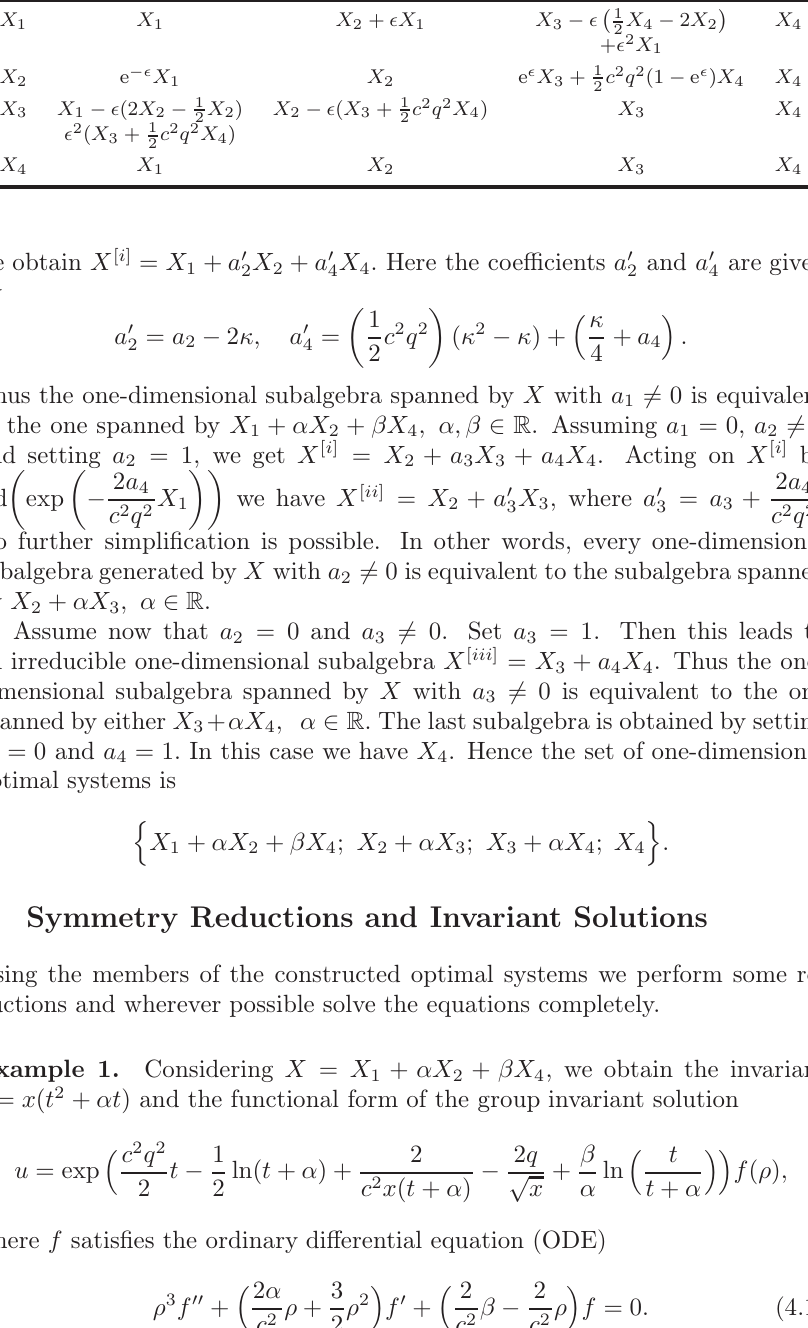
Table 2. Adjoint representation table. At position ( i,j ) we have Ad(exp ( ǫX for i = 1 ,..., 4 . Ad X